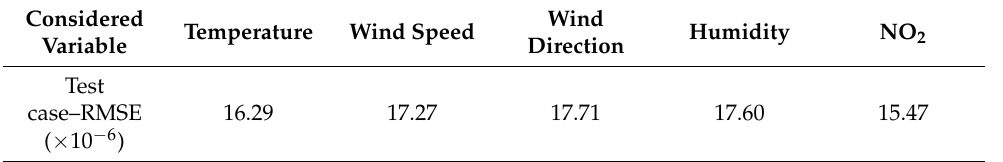
Table 6. The average of RMSEs [mol/m 2 ] on the testing dataset when each environmental variable was